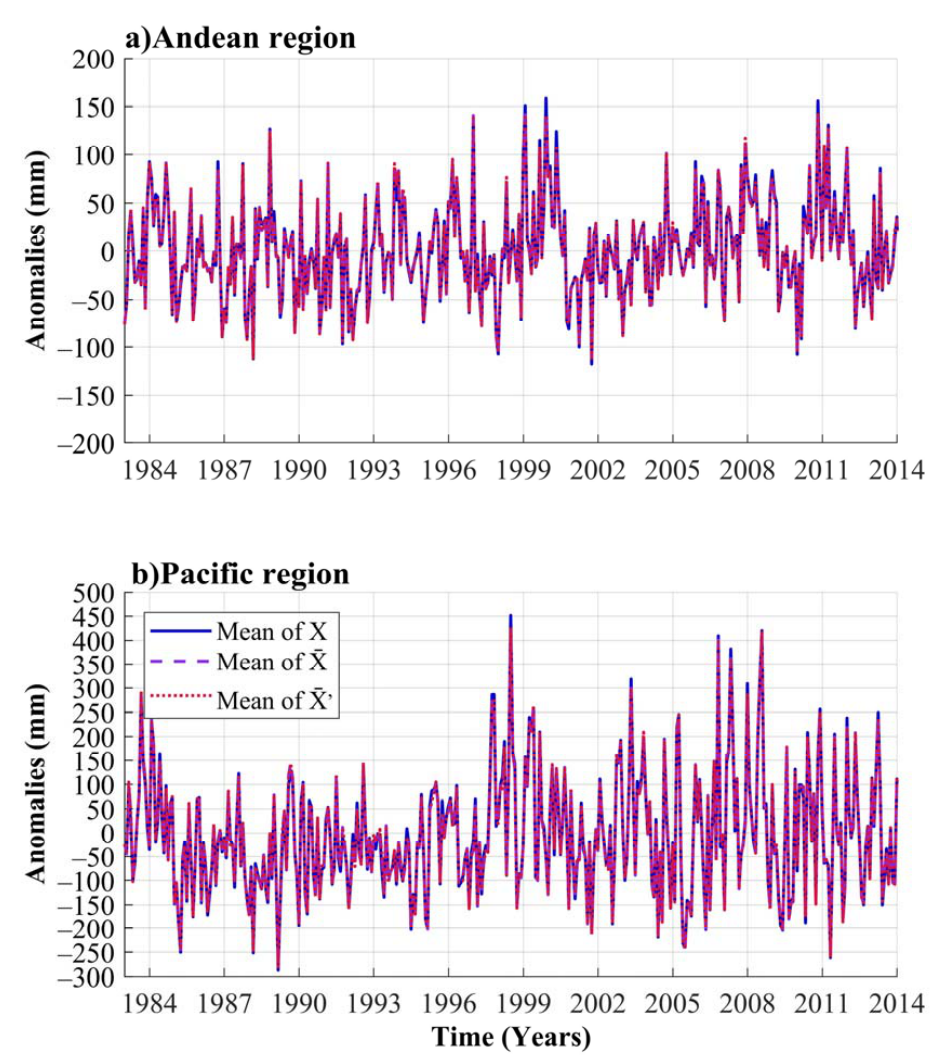
Figure 9. Comparison of the Inverse NLPCA output with the monthly rainfall anomalies observed during calibration. X is the input layer (rainfall anomalies), X n (cid:48) is the output layer (forecasted rainfall anomalies). ( a ) Andean region, ( b ) Pacific region.